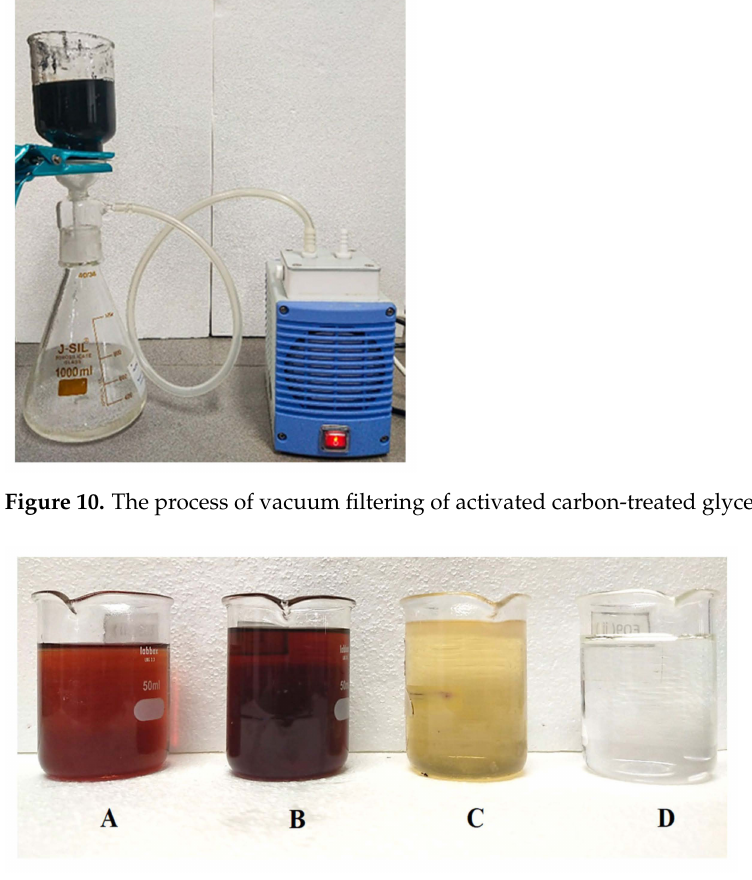
Figure 11. The color of the glycerol sample at various phases of the purification procedure. ( A ) Crude glycerol; ( B ) Methanol-free glycerol; ( C ) Neutralized purified glycerol; ( D ) Activated carbon treated purified